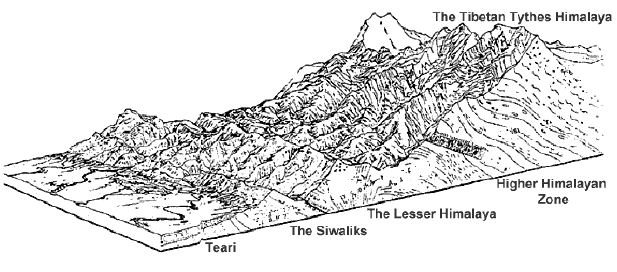
Fig. 1 . Physiographic regions vis-à-vis major geologic formations of the Nepal Himalaya. (DWIDP